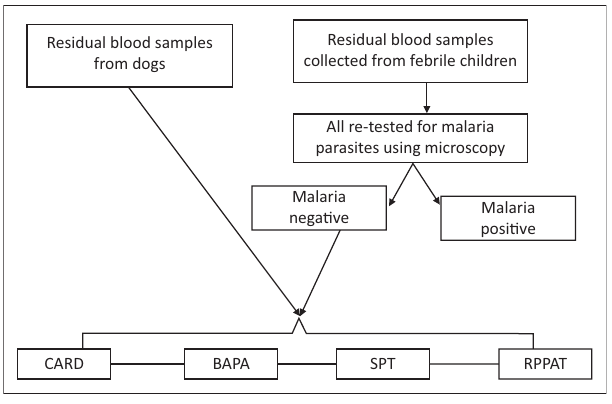
Residual blood samples collected from febrile